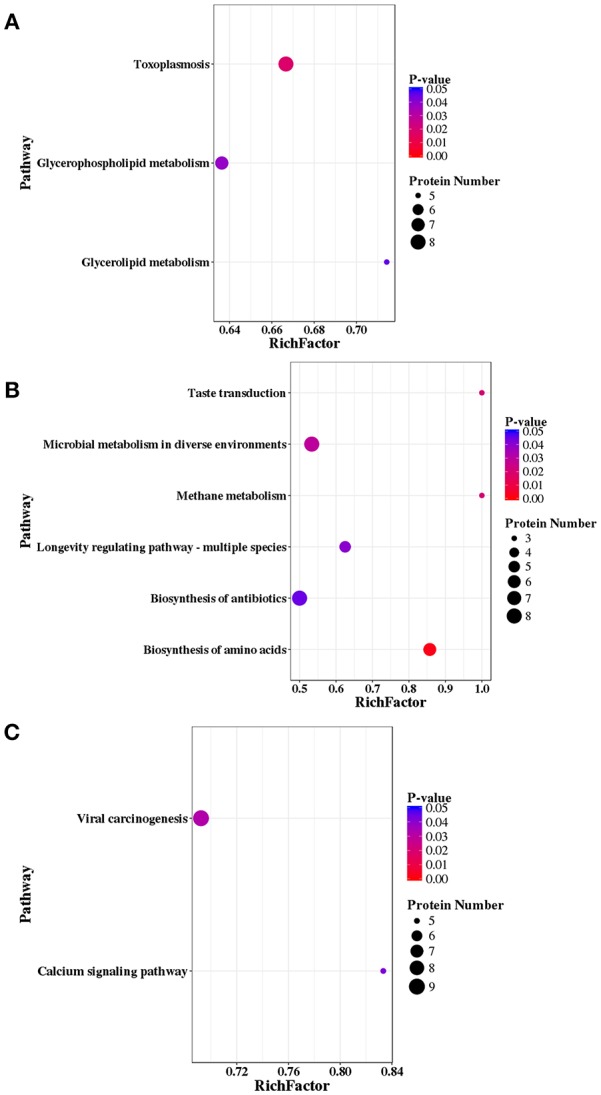
KEGG pathway analysis of differentially expressed phosphoproteins (DEPs) in RH strain when comparing RH/PRU strains, in PRU strain when comparing PRU/PYS strains, and in PYS strain when comparing PYS/RH strains. The vertical axis shows the significantly enriched KEGG pathways and the horizontal axis represents the rich factors corresponding to the pathways. Rich factor refers to the ratio of the number of DEPs to the number of all phosphoproteins in the pathway. Higher Rich factors indicate greater degrees of enrichment. The size and color of the node represent number of phosphoproteins and p-value of pathways. The scatter plots represent KEGG pathways of the DEPs in (A) RH strain when comparing RH/PRU strains, (B) in PRU strain when comparing PRU/PYS strains, and (C) in PYS strain when comparing PYS/RH strains, respectively.